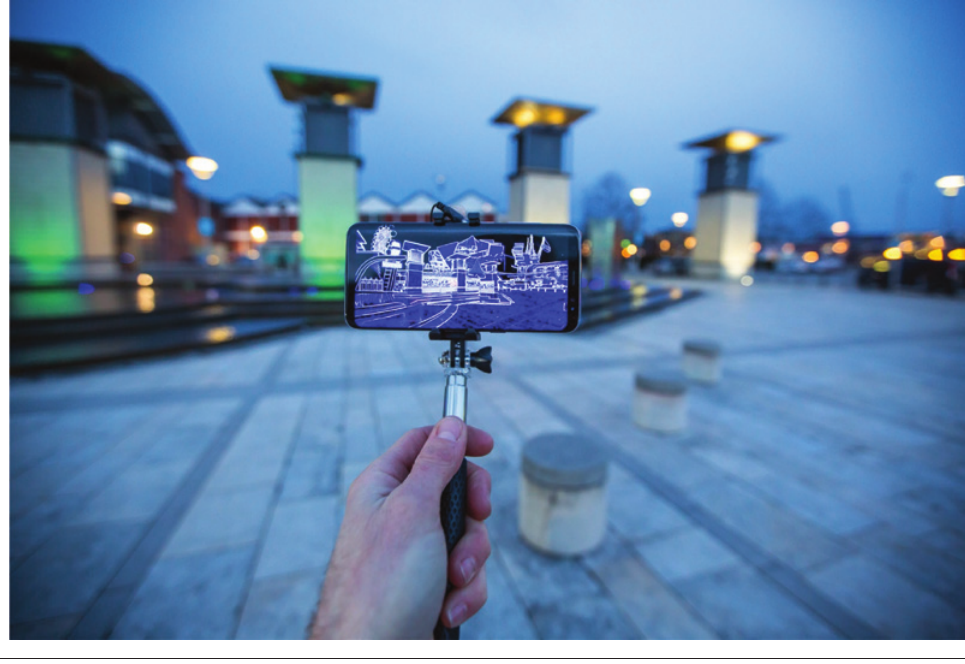
figure 2: Billennium , Uninvited Guests and Duncan speakman, Layered Realities , Millennium square, 2018 (aR animation by sam steer; photograph: Paul Blakemore)